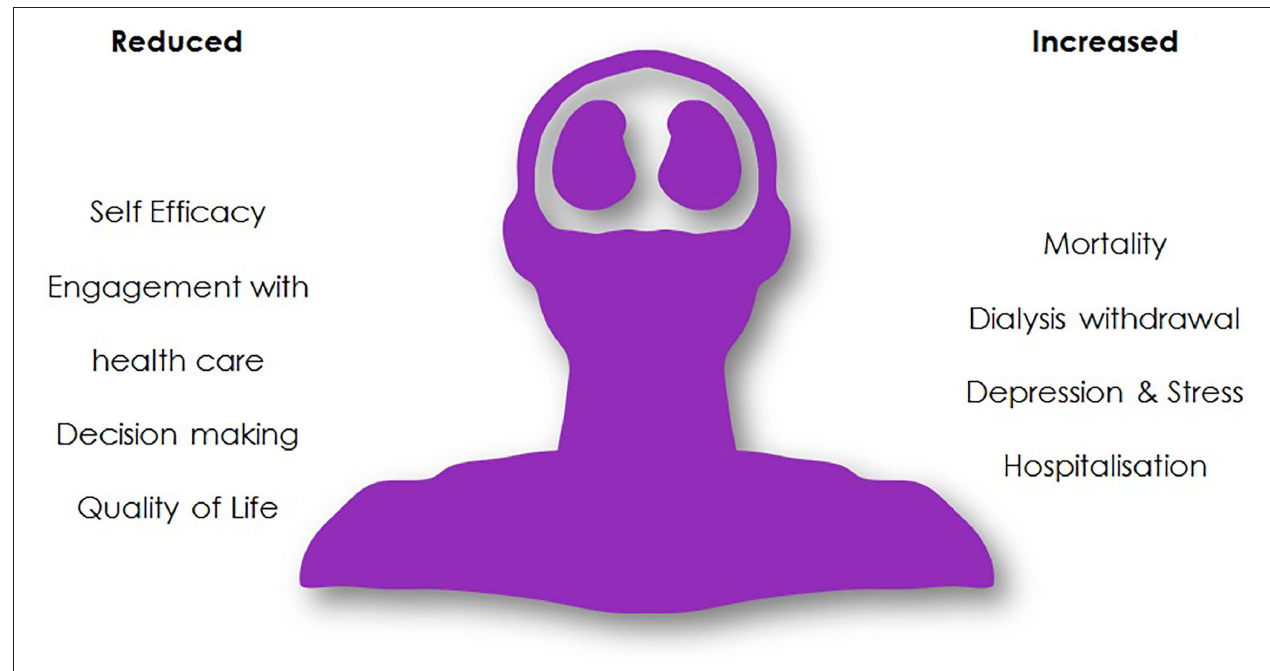
FIGURE 6 | Patient implications of cognitive impairment.